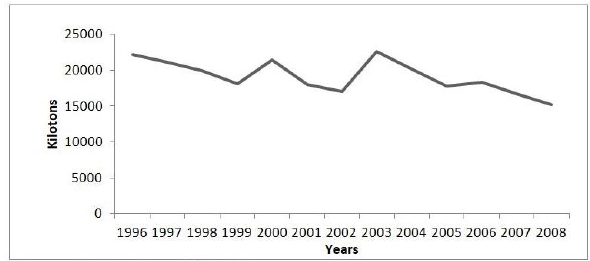
Fig. 3. CO 2 emissions embodied in exports from the EU-11* Fig. 8. Total CO 2 emissions embodied in exports from Poland partners to Poland- excluding Germany (1996-2008) (1996-2008) (Source: Authors’ own (Source: Authors’ own elaboration) * EU-11 partners for this research are the following: AUT, CSZ, DNK, ESP, FIN, FRA, GBR, HUN, ITA, NTH, SWE